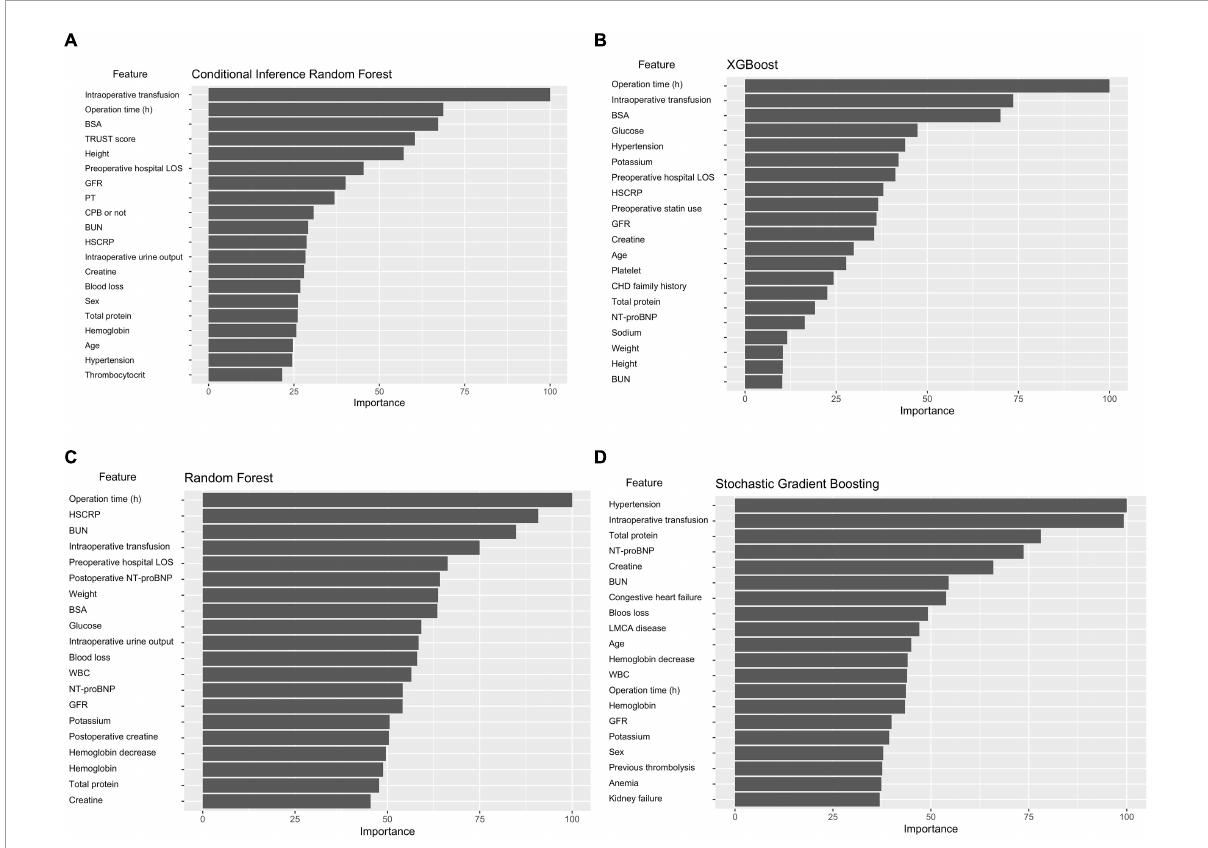
FIGURE4 Variable importance of predictors in the ML models. The variable importance is a scaled measure to have a maximum value of 100. The predictors with variable importance of the top 20 are shown. (A) Conditional inference random forest. (B) Xgboost. (C) Random forest. (D) Stochastic gradient